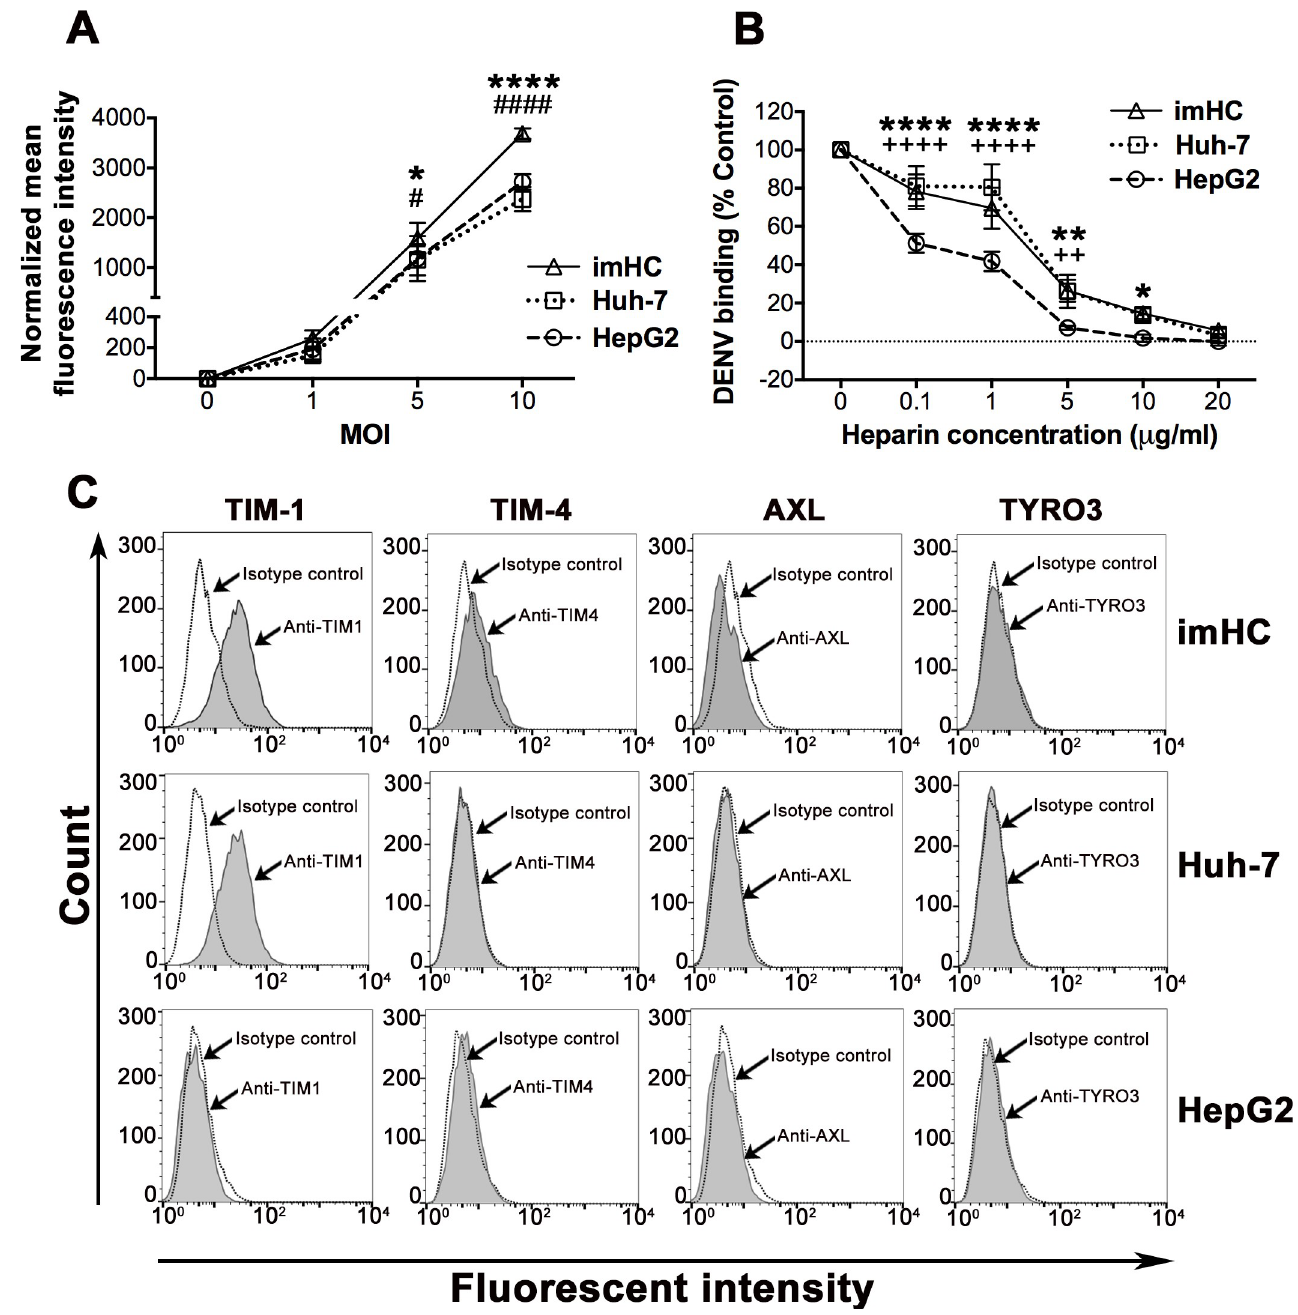
Fig 1. Characterization of DENV binding ability and potential DENV receptors of imHC in comparison with commonly used hepatoma cell lines (Huh-7 and HepG2). ( A ) The three hepatic cell types (imHC, Huh-7, HepG2) were incubated with different MOIs of DENV-2 for 1 h at 4˚C, and the levels of DENV-2 bound to the cell surface were determined by immunofluorescent staining with anti-E antibody followed by flow cytometric analysis. In the absence of DENV, each cell type has unique background immunofluorescent staining. Therefore, the mean fluorescence intensity (MFI) values from the control (no DENV) condition of each cell type were subtracted from MFI values obtained from the corresponding cells in the presence of DENV. Data shown are mean ± S.D. of the normalized MFI values from three independent experiments. ( B ) The three hepatic cell types were incubated with DENV-2 at MOI of 5 for 1 h at 4˚C in the presence of heparin at different concentrations, and the bound DENV levels were determined as described in A . The percentages of DENV binding to cells were calculated by comparing the subtracted MFI values of heparin-containing conditions to those from the control (no heparin) conditions of the same cell type. Data shown are mean ± S.D. of values from three independent experiments. An asterisk ( � ), “ # ” symbol and “ + ” symbol indicate significant differences between imHC vs HepG2, imHC vs Huh-7, and Huh-7 vs HepG2, respectively ( � P < 0.05; �� P < 0.01; ���� P < 0.0001). ( C ) Representative flow cytometry histograms showing signals on the surface of three cell types stained with specific antibodies for indicated DENV receptors (gray) compared with the isotype control.